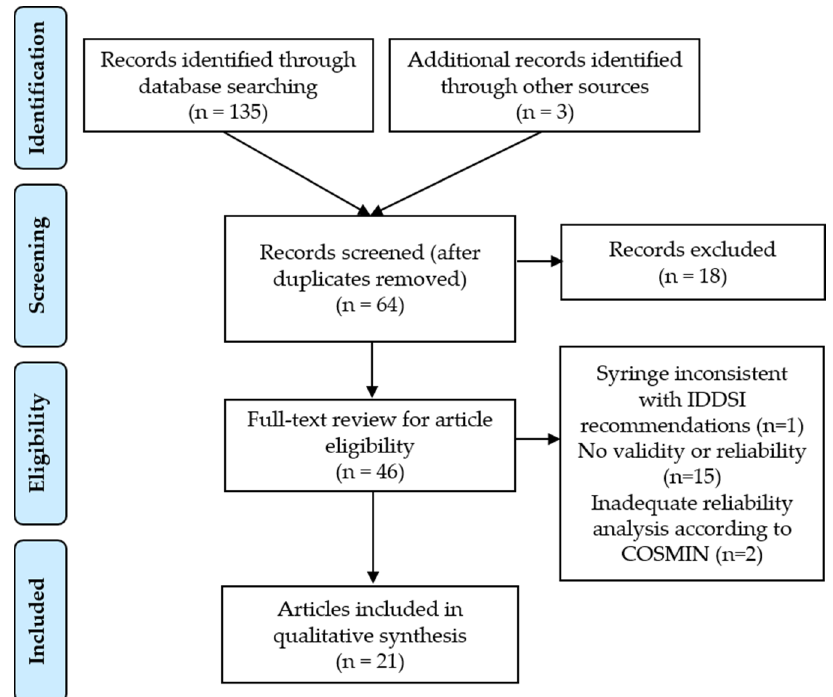
Figure 2. PRISMA Flow Diagram of systematic review process.